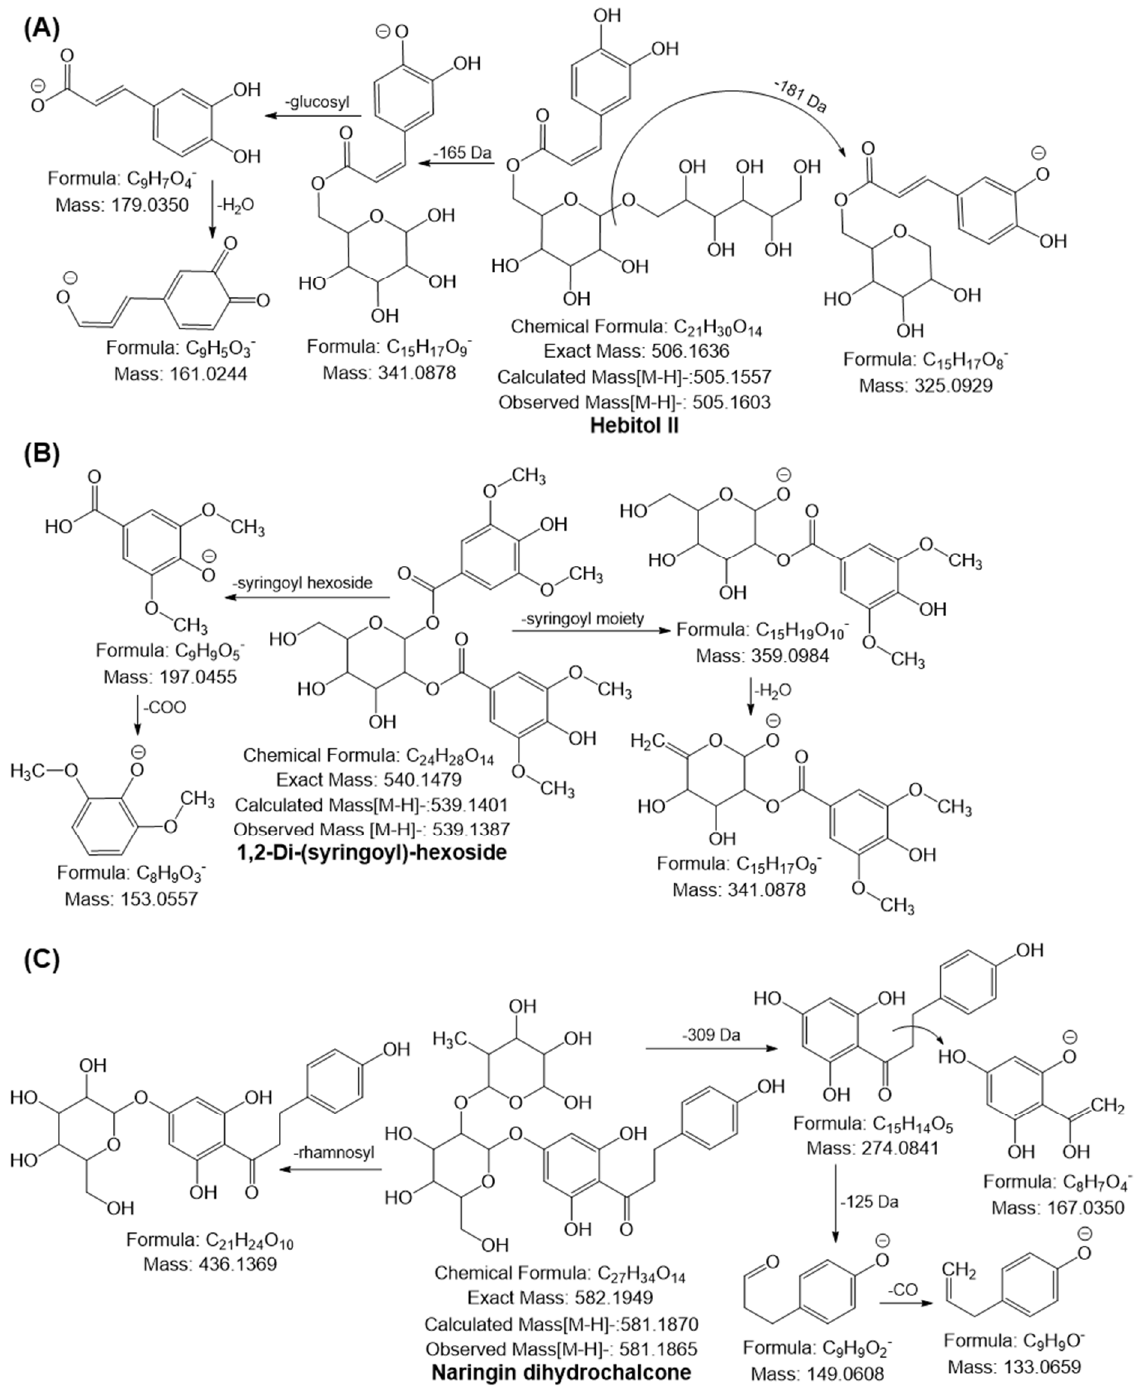
Figure 3. Possible mass fragmentation behavior of identified compounds in RADP. ( A ) Hebitol II, ( B ) 1,2—di—(syringoyl)—hexoside, and ( C ) naringin dihydrochalcone.